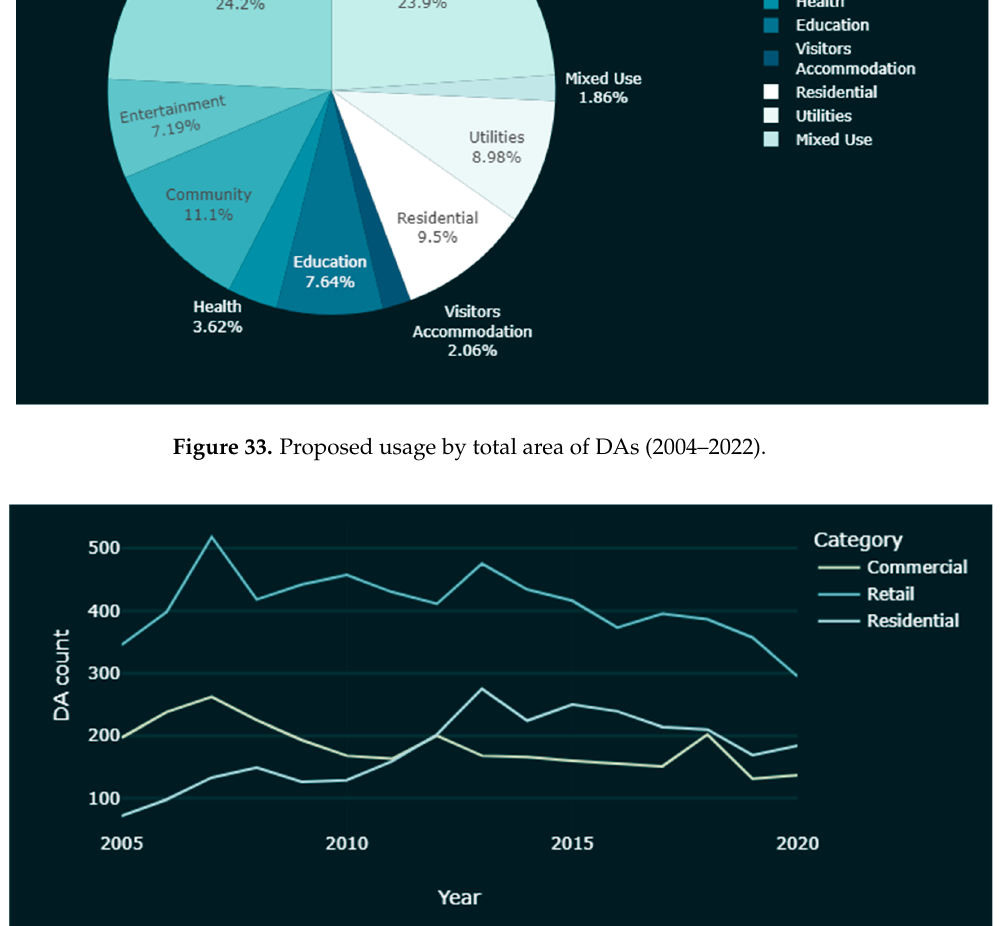
Figure 34. Number of approved DAs by proposed uses over time (2005–2021).